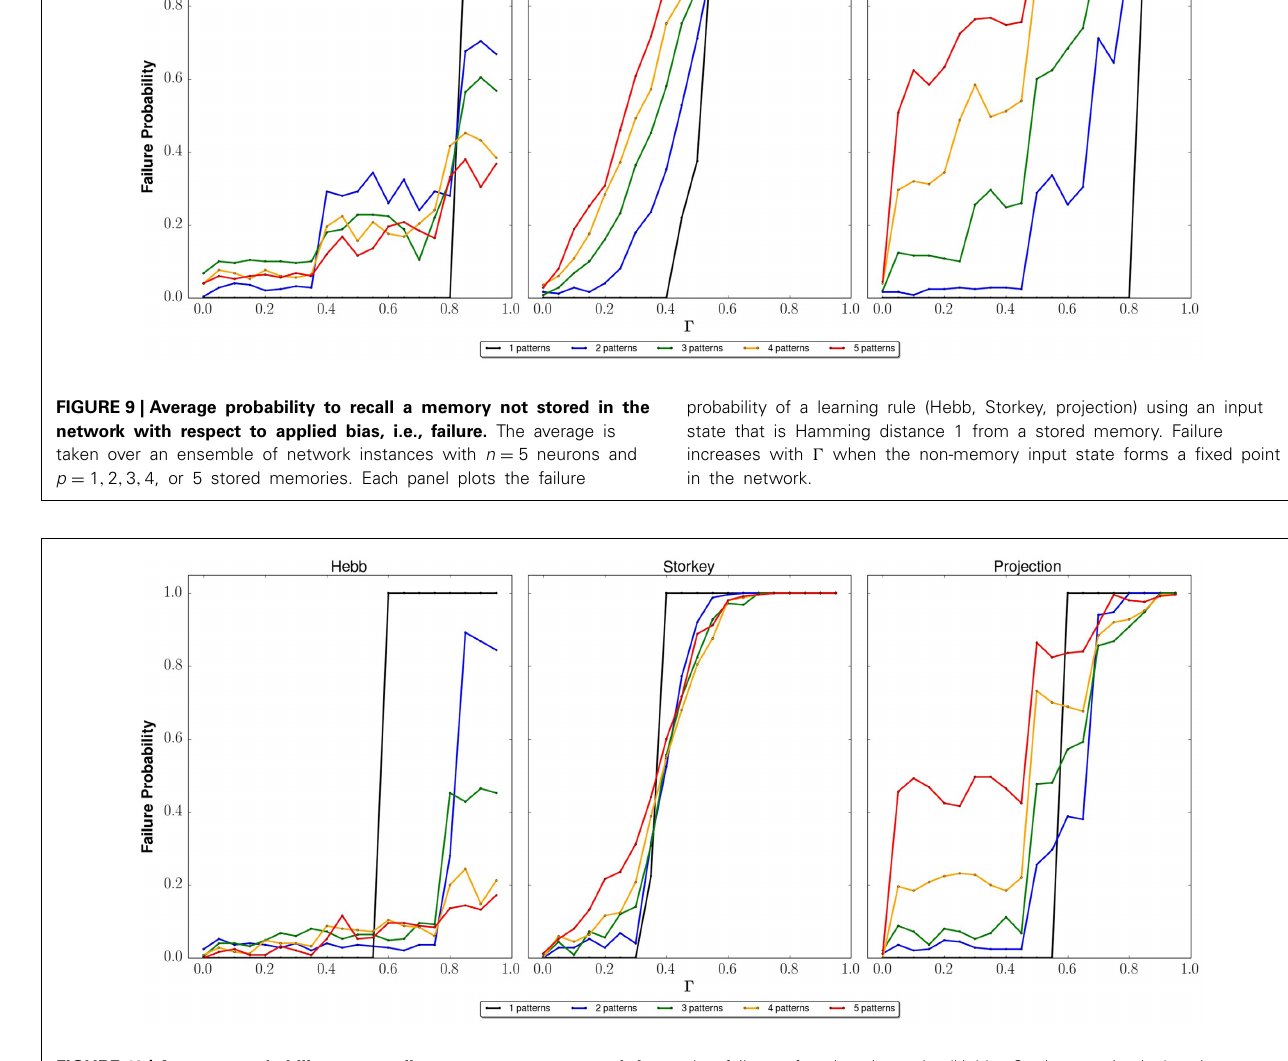
the failure of a learning rule (Hebb, Storkey, projection) using an input state that is Hamming distance 2 from a stored memory. Failure increases with (cid:6) when the non-memory input state forms a fixed point in the